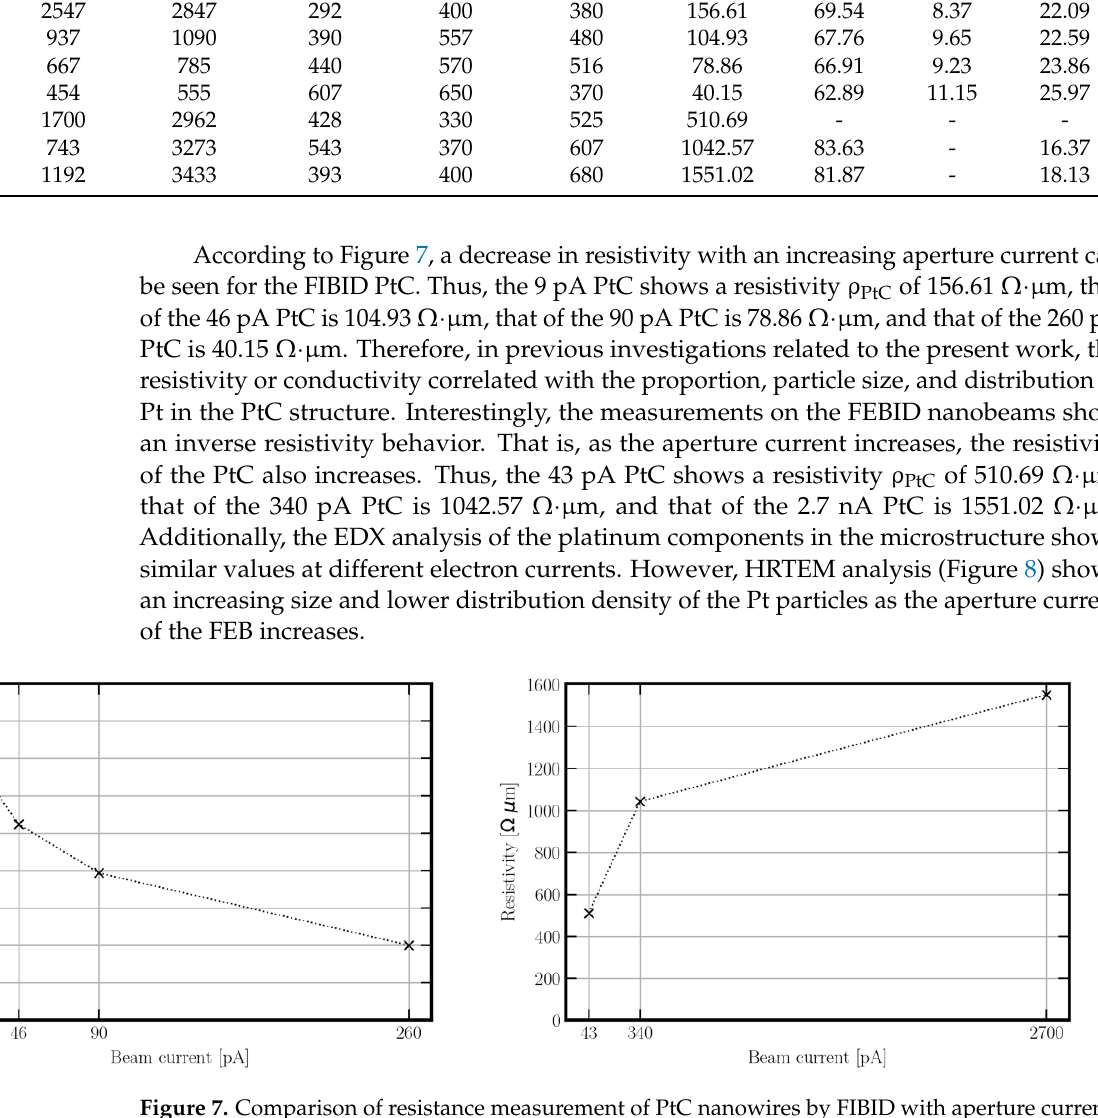
Figure 7. Comparison of resistance measurement of PtC nanowires by FIBID with aperture currents of 9, 46, 90, and 260 pA ( left ) and FEBID with 43, 340, and 2.7 nA ( right ).